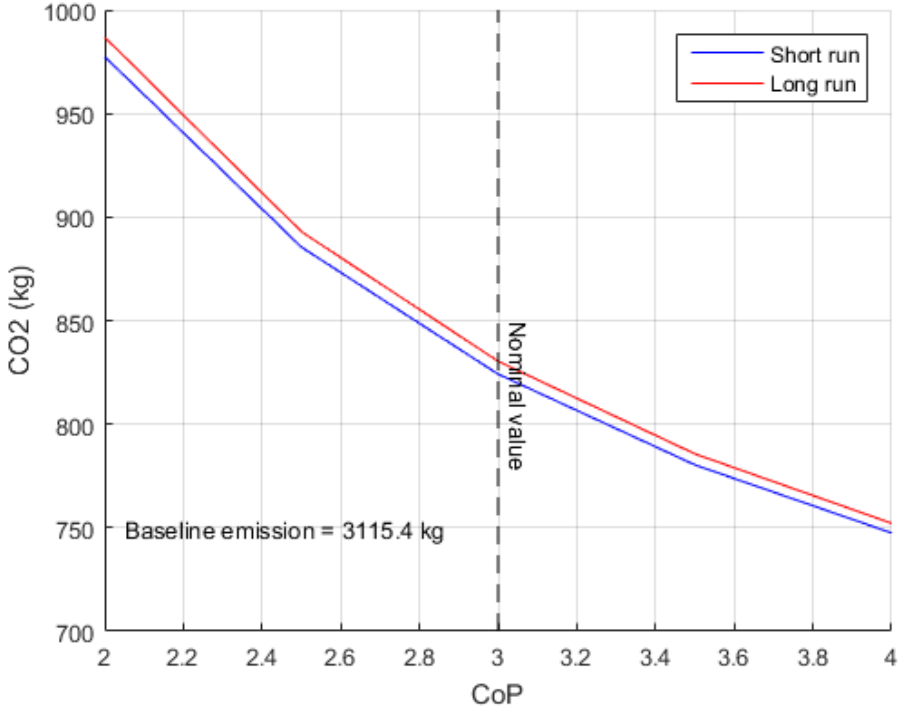
Figure 14. Influence of heat pump design on environmental performance.